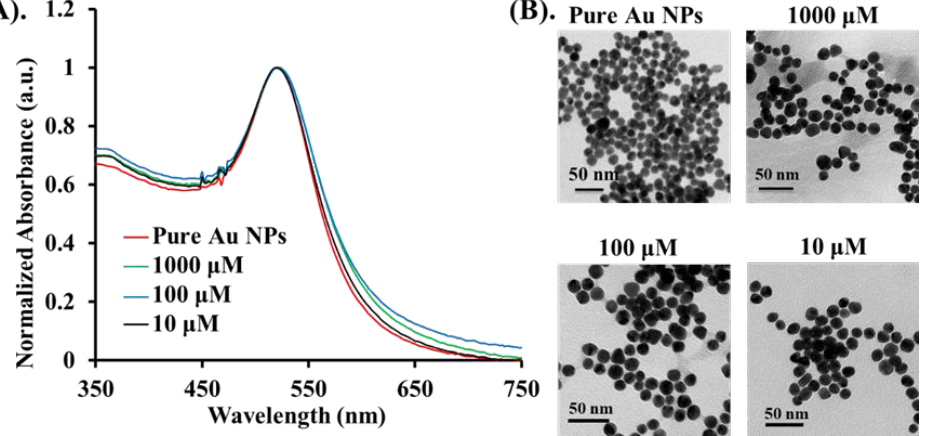
Figure 3. Different concentrations (10 μM, 100 μM, and 1000 μM) of Au@Cys NPs: ( A ) the UV–VIS absorption spectrum, and ( B ) TEM images. absorption spectrum, and ( B ) TEM